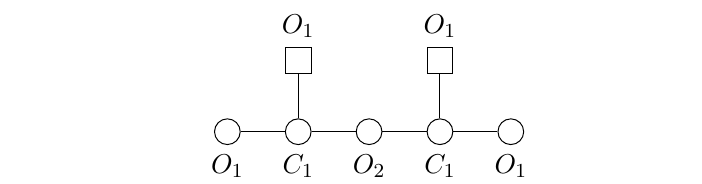
Figure 66. Quiver obtained from brane systems in the second row of table 6. Its Higgs branch is M H = D 3 .